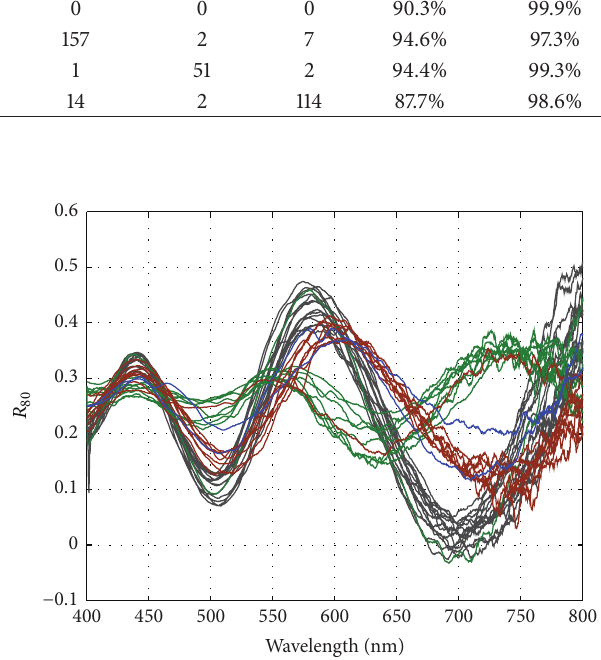
Figure 4: Representative multiwavelength angular scattering spec- tra of CNS (grey), S. haemolyticus (red), S. hominis (green), and S. warneri